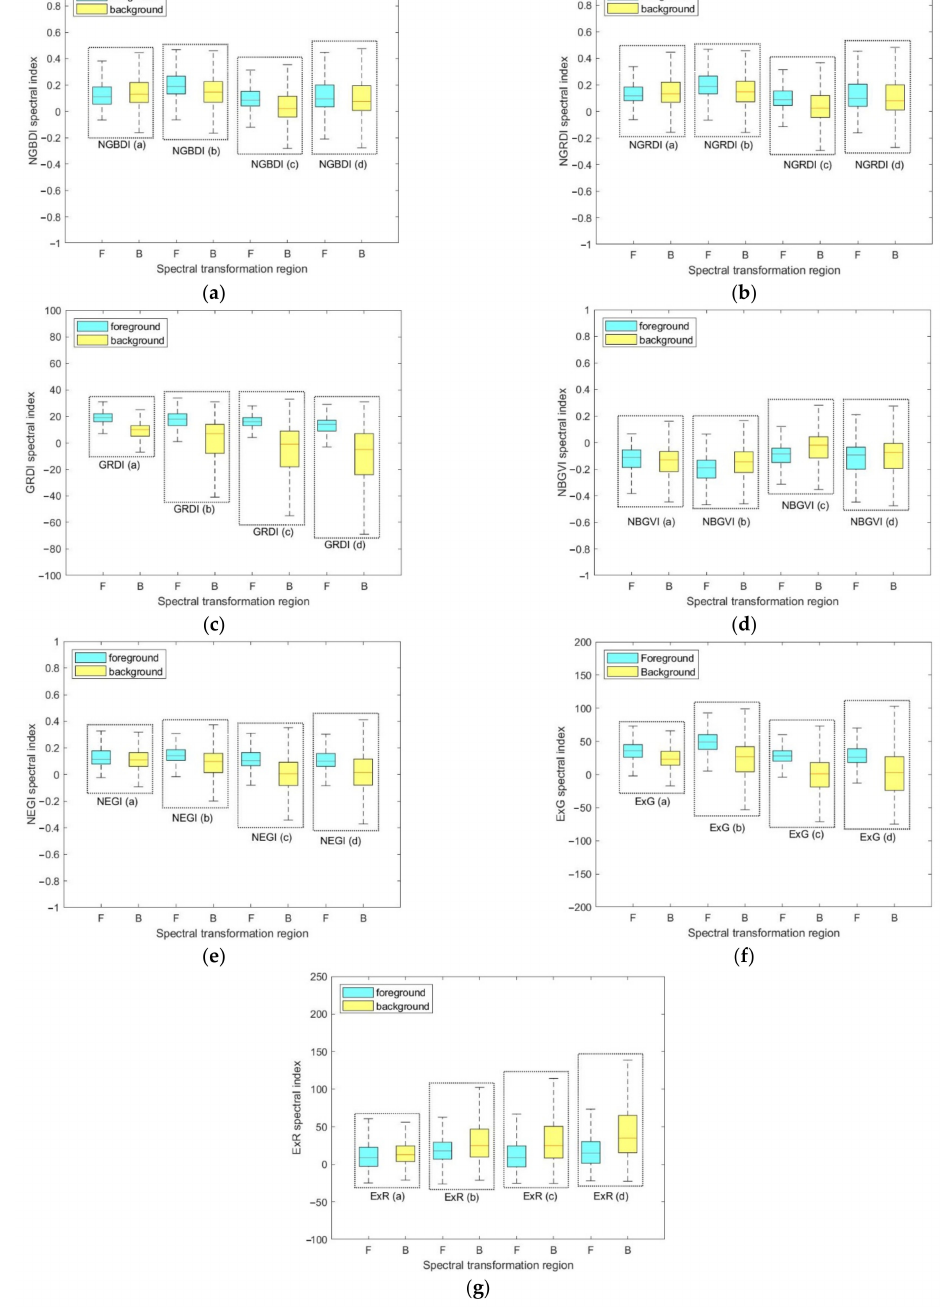
Figure 4. The statistical results of the four transformed sample images by ( a ) NGBDI, ( b ) NGRDI, ( c ) GRDI, ( d ) NBGVI, ( e ) NEGI, ( f) ExG, and ( g )